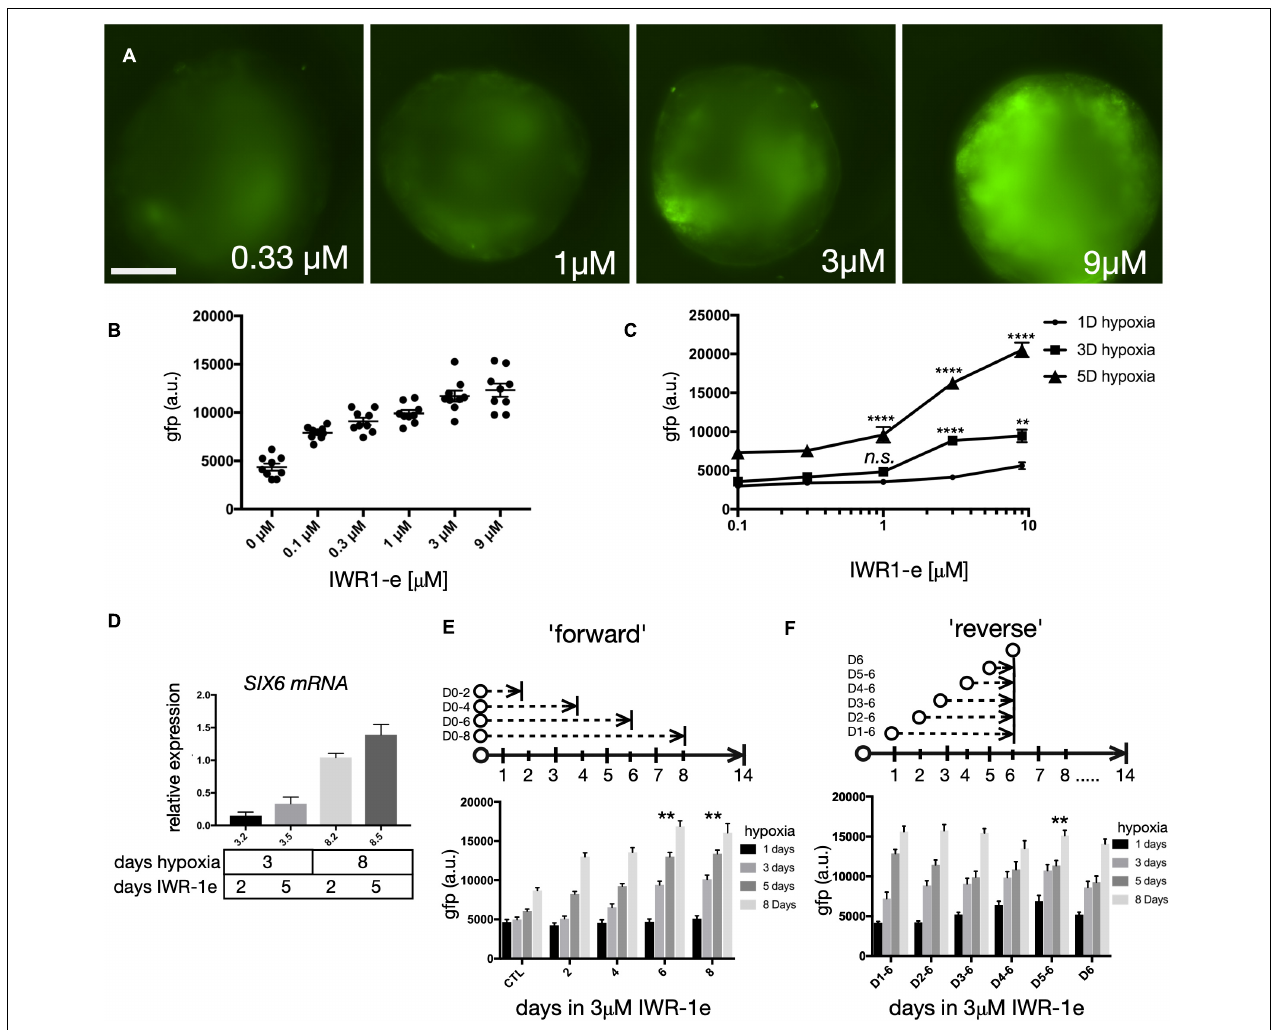
FIGURE 3 | Dose and time of WNT signaling on eye field development. (A) SIX6-GFP fluorescence imaging of live organoids at day 14 that were grown under hypoxia for 5 days and treated with 0.33, 1, 3, and 9 µ M of IWR1e from days 1–6. (B) Average intensity fluorescence of SIX6-GFP organoids following a dose response of IWR1e (0.11, 0.33, 1.0, 3.0, and 9.0 µ M; n = 9 individual organoids; 54 total). (C) The influence of a dose response of IWR1-e on fluorescence intensity for cells grown under different hypoxic conditions (1-, 3-, and 5 days) and imaged at D14 ( n = 10; 180 total). (D) Quantitative PCR (qPCR) showing relative expression of SIX6 in organoids grown under hypoxia for 3 and 8-days of hypoxia and treated with 3.0 µ M IWR1e for 2 or 5 days ( n = 3; 12 total). (E) GFP intensity measurements at day 14 following a forward time course in which IWR1e was added for 0, 2, 4, 6, or 8 days under varying days of hypoxia ( n = 10 individual organoids; 200 total). (F) GFP intensity measurements at day 14 following a reverse treatment scenario, in which IWR-1e was added during days 1–6, 2–6, 3–6, 4–6, 5–6, and only on D6 after variable lengths of hypoxia ( n = 10; 240 total). gfp a.u. = GFP arbitrary unit; Statistical significance determined by one-way ANOVA; ** = statistically significant ( p < 0.01), **** = statistically significant ( p < 0.0001), n.s = not significant. Scale bar = 300 µ